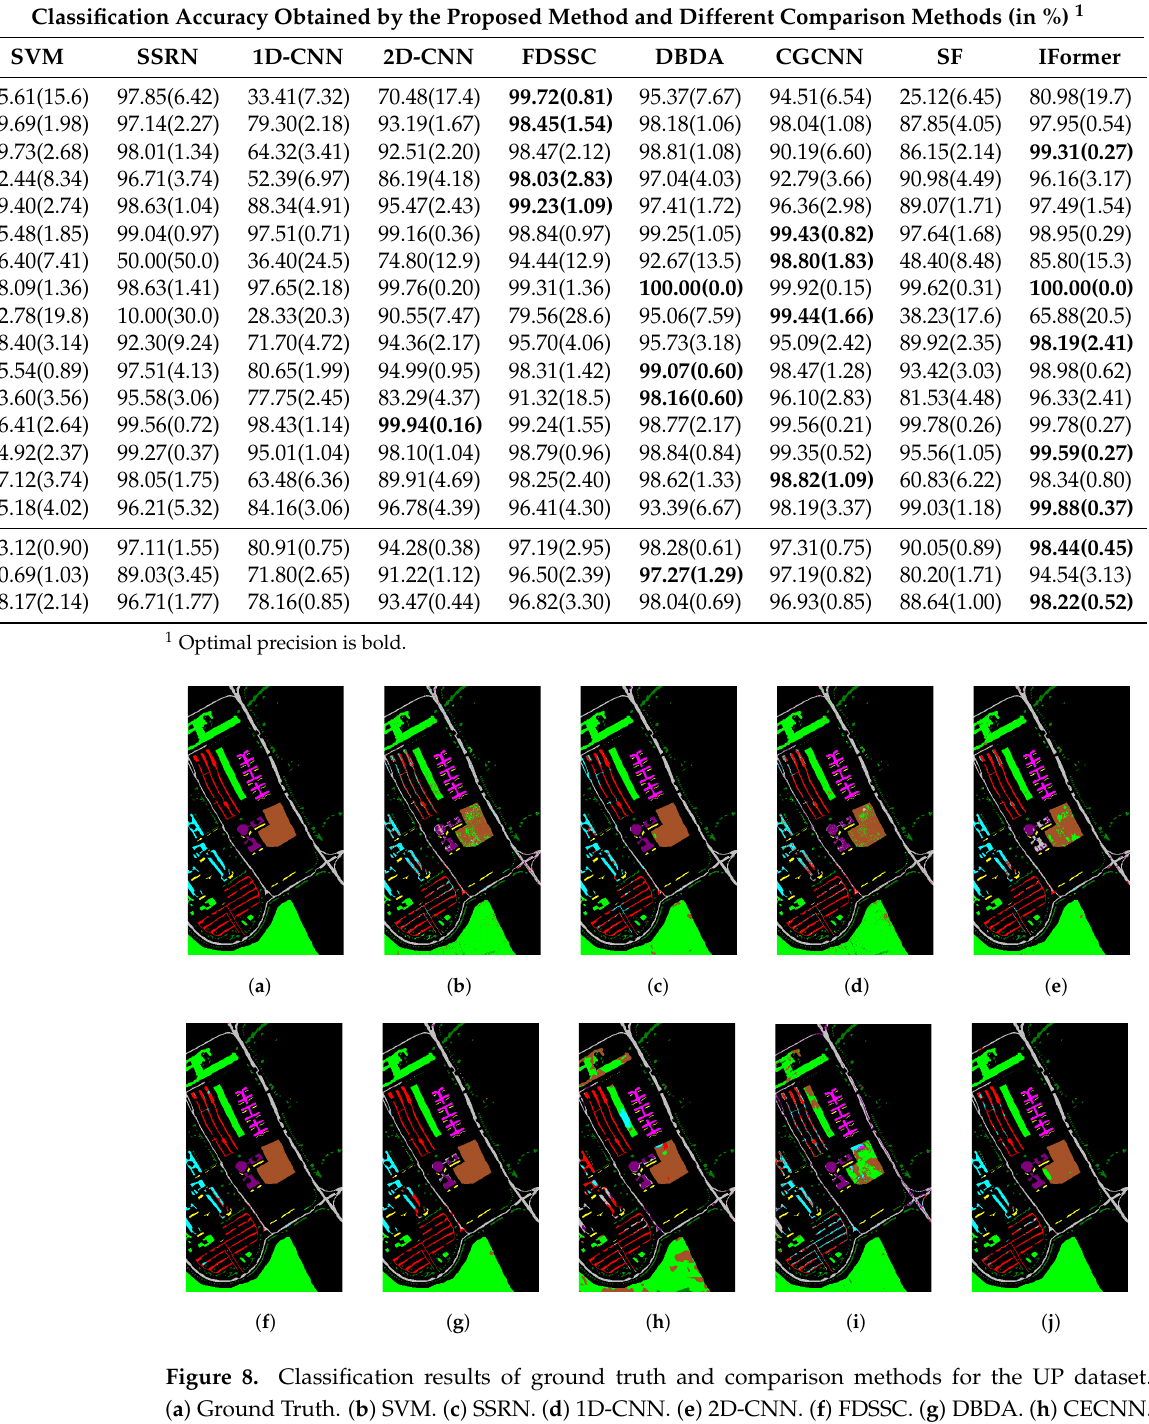
Table 5. Accuracy comparison of different methods on IP dataset.